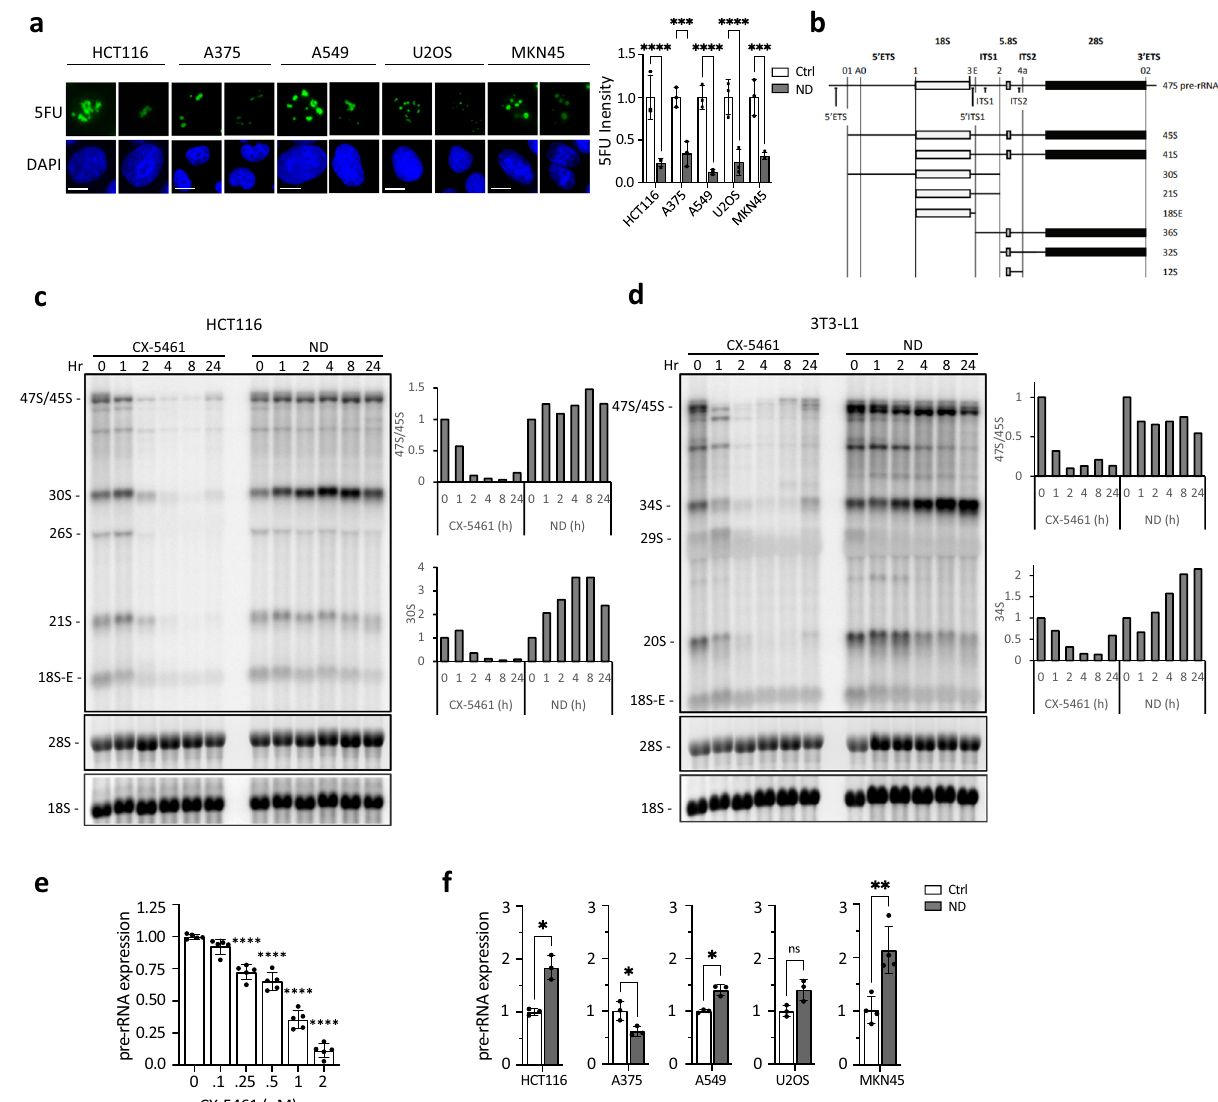
Fig. 1 Nutrient deprivation upregulates pre-rRNA expression. a 5FU labeling under nutrient deprivation (24 h). Cancer cell lines were cultured under ND (-Glucose – Amino acids – FBS) for 24 h, and pre-rRNA synthesis was measured by 5FU metabolic labeling. Data represent the mean ± SD of three images. P values (left to right): <0.0001, 2 × 10 − 4 , <0.0001, <0.0001, 0.0001 ( ∗∗∗ p < 0.001; ∗∗∗∗ p < 0.0001, statistical analysis by two-way ANOVA). Scale bar, 10 μ m. b Schematic of pre-rRNA processing. 47S processing produces intermediate precursors which mature to 18S, 28S, and 5.8S rRNAs. The primary 47S pre-rRNA contains two external transcribed spacers (5 ′ ETS and 3 ′ ETS) and two internal transcriber spacers (ITS1 and ITS2). c Left: Pre-rRNA expression in HCT116 treated to CX-5461 or ND using northern blotting (ITS1 Probe). Right: Quanti fi cation of 47S/45S and 30S intermediates in response to CX-5461(10 µ M) /ND. The full northern blot is shown in Supplementary Fig. 1b. d Left: Pre-rRNA expression in 3T3-L1 cells treated to CX-5461 or ND using northern blotting (ITS1 Probe). Right: Quanti fi cation of 47S/45S and 34S intermediates in response to CX-5461/ND. The full northern blot is shown in Supplementary Fig. 1c. e Expression of pre-rRNAs (47S/45S/30 S species) after CX-5461 (10 µ M, 8 h) exposure. Data represent mean ± SD of n = 5 technical replicates. P values (left to right): <0.0001, <0.0001, <0.0001, <0.0001 ( ∗∗∗ p < 0.0001, statistical analysis by one-way ANOVA). f Expression of pre-rRNAs (47S/45S/30S species) after 24 h ND in HCT116, A549, U2OS, and MKN45 cells, as assessed using qRT-PCR. Data represent mean ± SD of n = 3 technical replicates. P values (left to right): 0.0132, 0.0213, 0.0115, 0.0040 ( ∗ p < 0.05; ∗∗ p < 0.01, statistical analysis by two-way